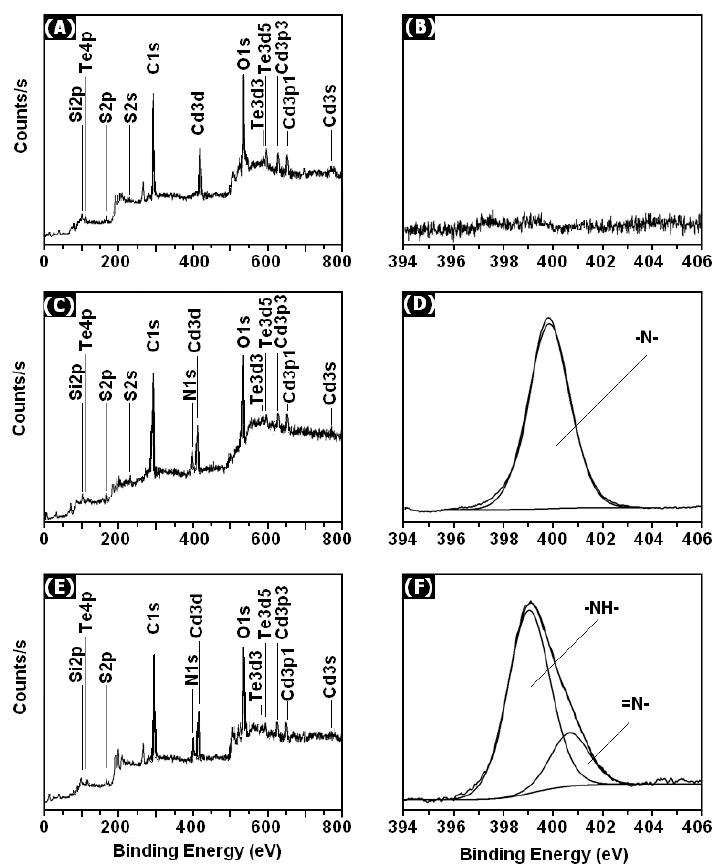
Figure 5. Wide scans and N1s core-level spectra of ( A , B ) PPEGMA- g -CdTe, ( C , D ) DSC- f -PPEGMA- g -CdTe, and ( E , F ) Ado- i -PPEGMA- g -CdTe nanohybrids, respectively.